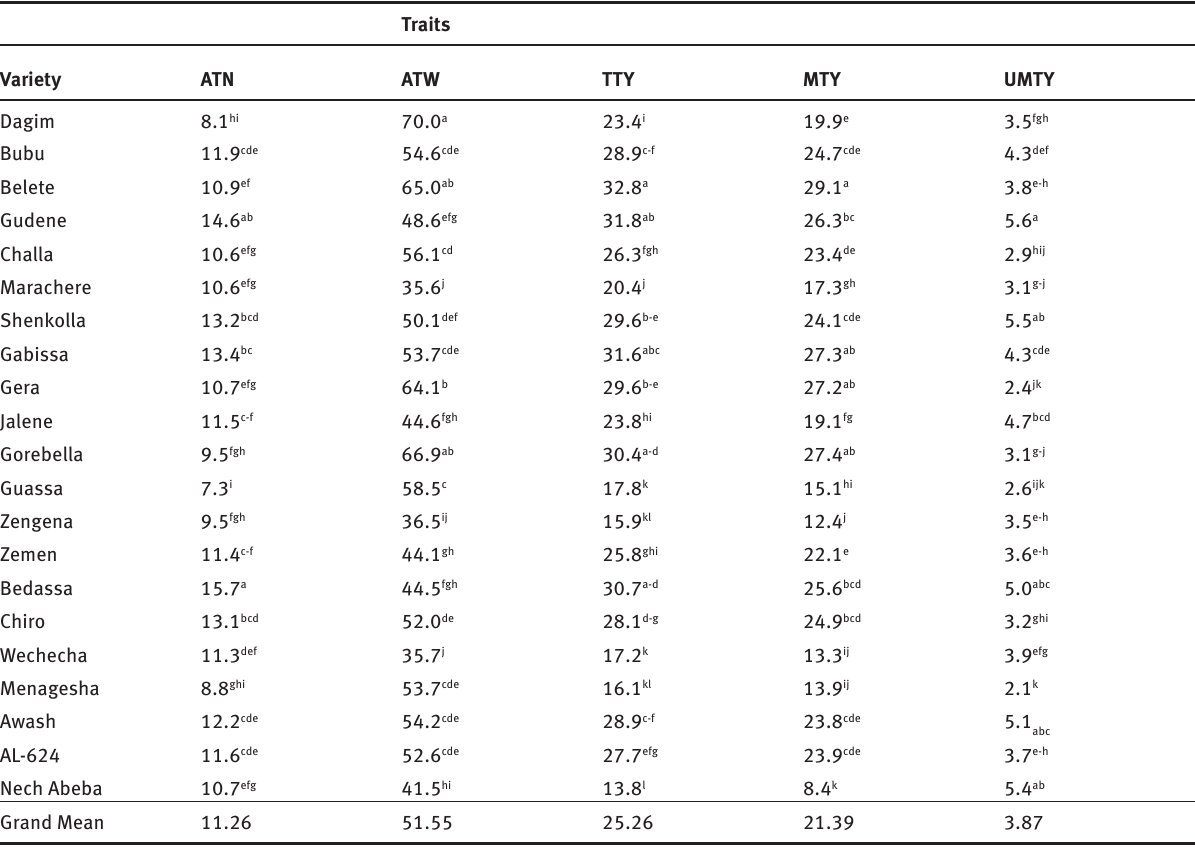
Table 5: Mean performances of 21 potato varieties for tuber yield and yield related traits evaluated at Holetta and Adea Berga in 2017